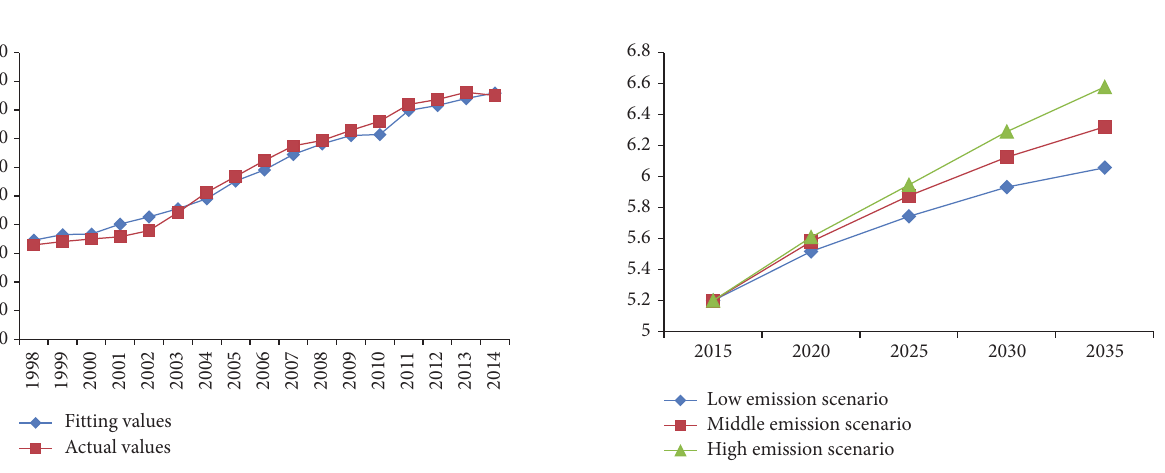
Figure 7: The fitting values and the actual values of carbon emissions from 1998 to 2014 (a hundred million tons).